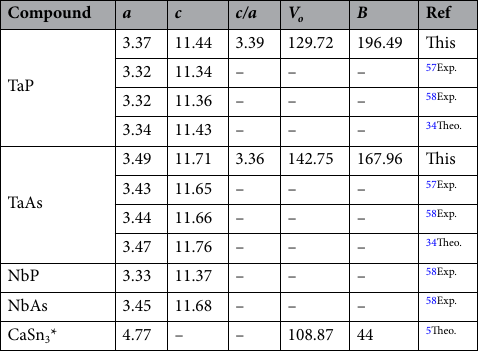
Table 1. Calculated and previously estimated lattice constants a (Å) and c (Å), c / a ratio, equilibrium volume V o (Å 3 ) and bulk modulus B (GPa) of TaP and TaAs. Relevant structural data for other binary WSMs are also given.